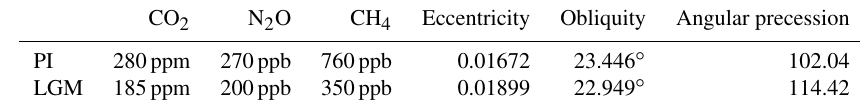
Table 1. Boundary conditions adapted in the WRF simulations for PI and LGM based on the PMIP3 protocol.